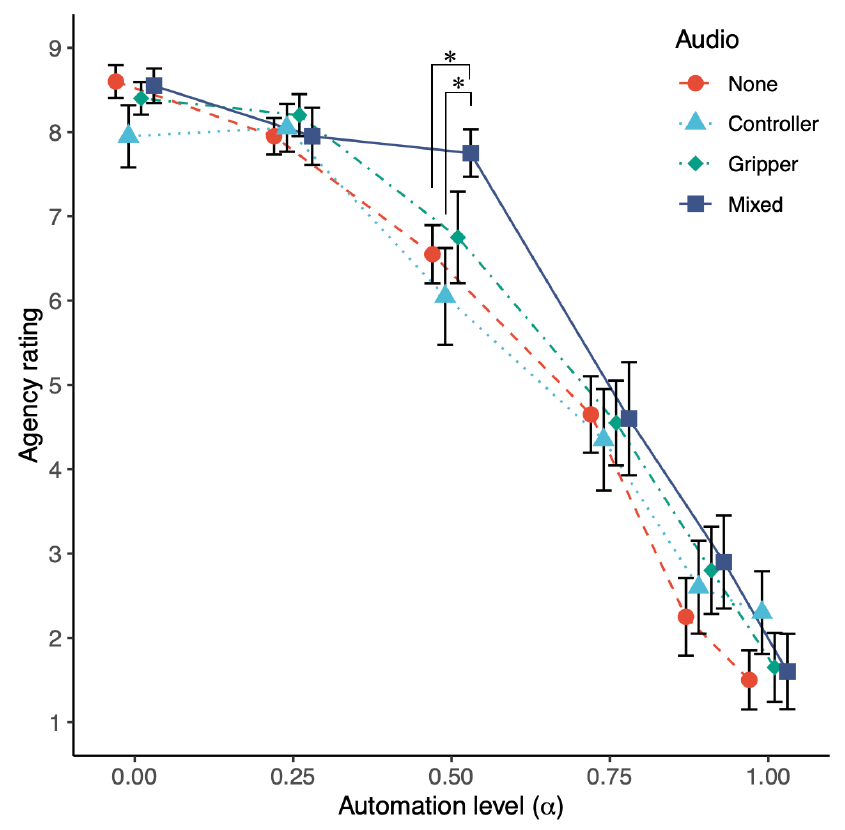
Figure 6. Mean agency ratings at each level of automation under four different auditory feedback conditions. Error bars represent standard errors. The SoA decreases with increasing automation level and is significantly higher in mixed condition than in none and controller condition when the automation ratio α is 0.50 (*: p <